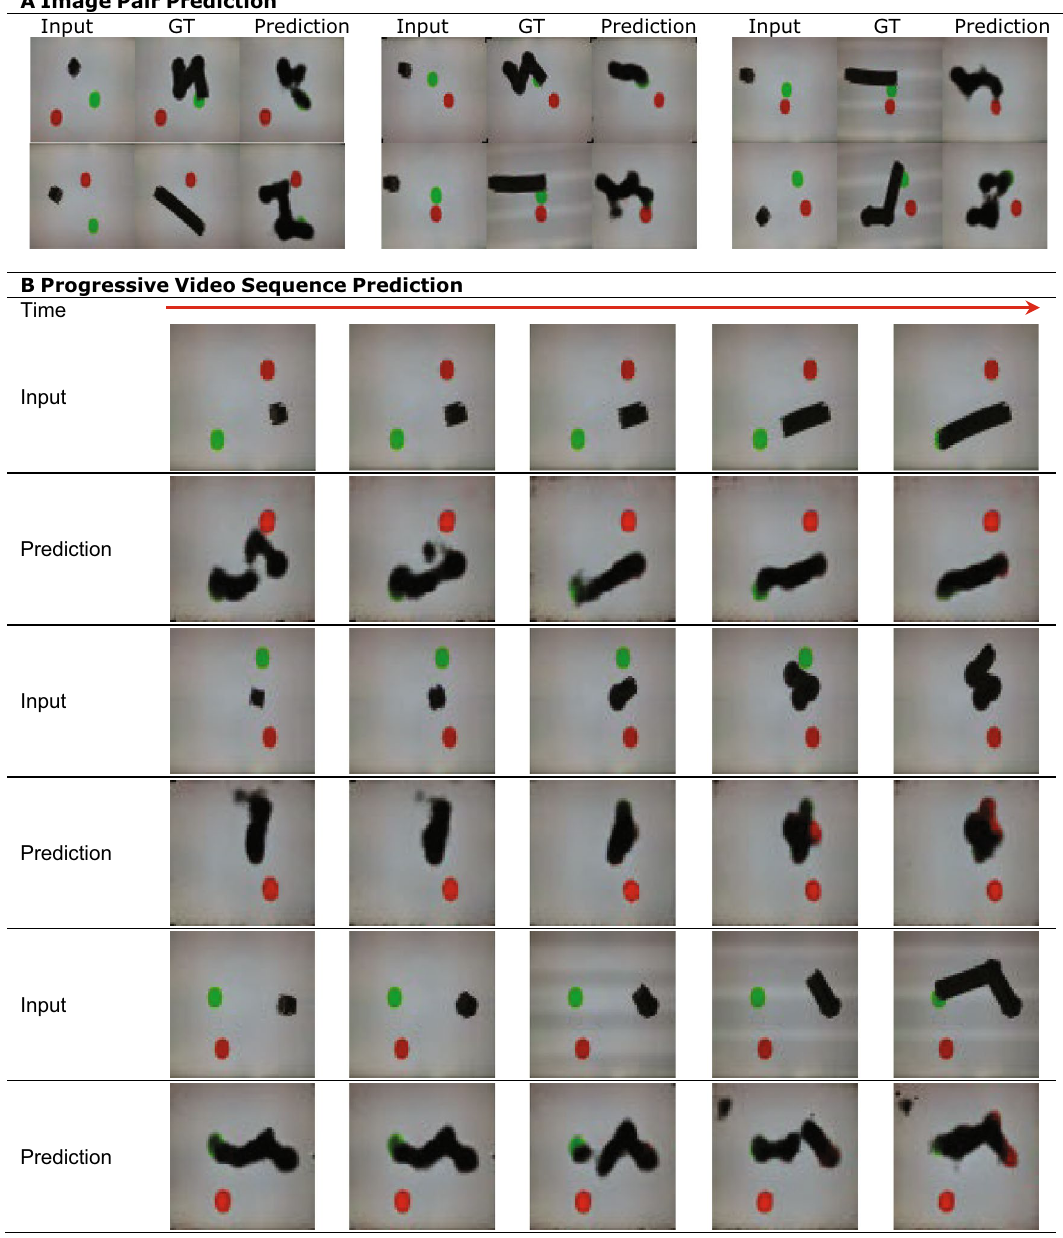
Figure 5. Handling ambiguity. This observer AI is trained only on the first frame as input. Therefore, there are multiple possible future trajectories possible based on only this input frame. As shown in ( A ). Image Pair Prediction, the observer handles this ambiguity by outputting one of the heuristic behaviors or as a blurry trajectory. Although our observer model is trained using start and end image pairs (with integration of all the past frames), the observer can be used in an online fashion during evaluation. ( B ) Progressive Video Sequence Prediction shows the prediction results using our model across multiple time